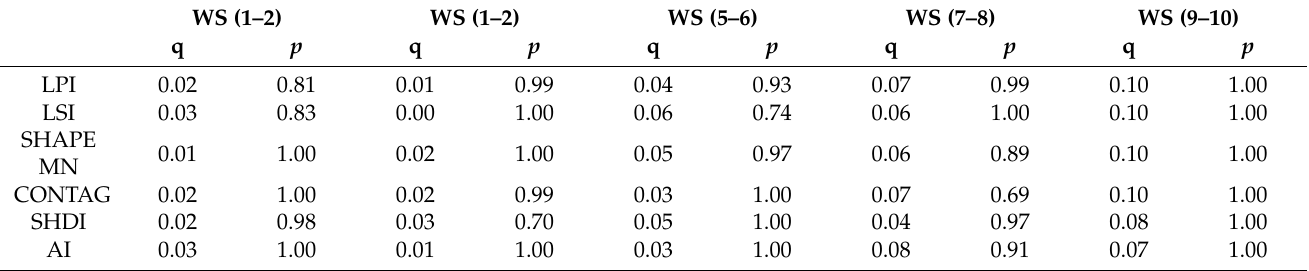
Table A2. The q and p values of factor detectors for O 3 concentration and landscape patterns